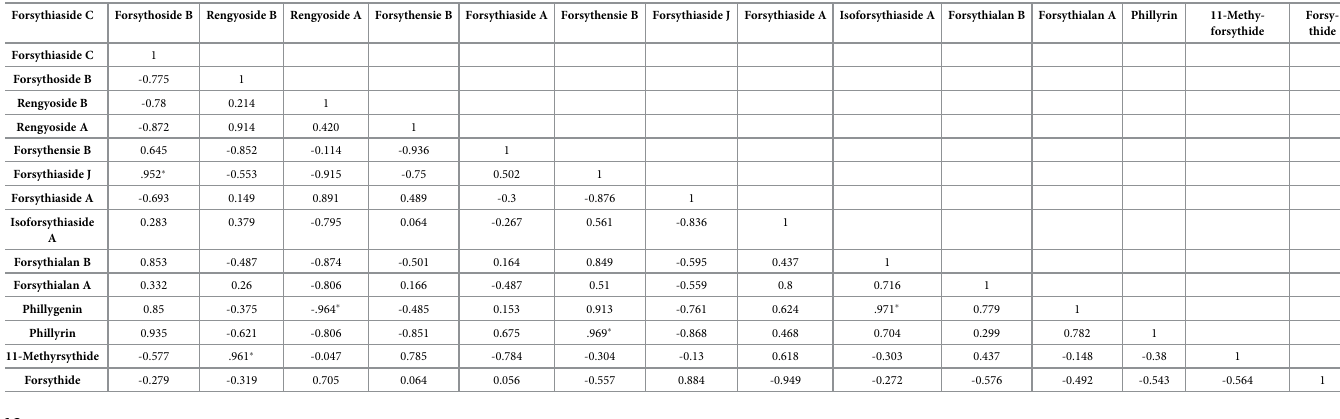
Table 1. Correlation analysis of Forsythia related metabolites in leaves of Forsythia suspense .